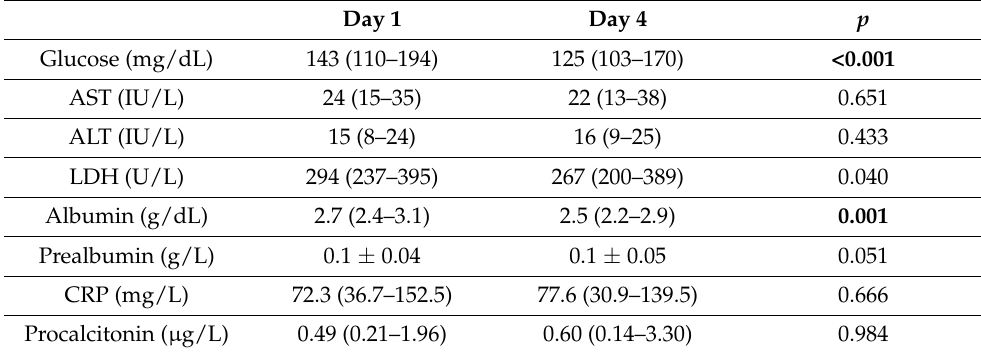
Table 3. The laboratory values of the patients on the first and fourth study days.